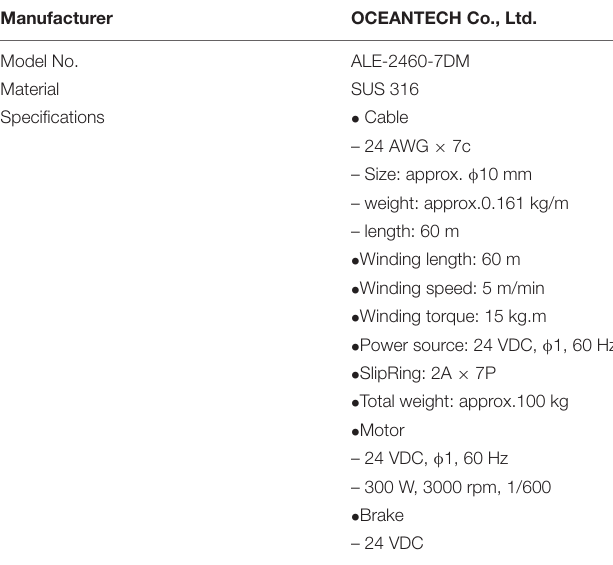
TABLE 4 | Specifications of the winch mounted on